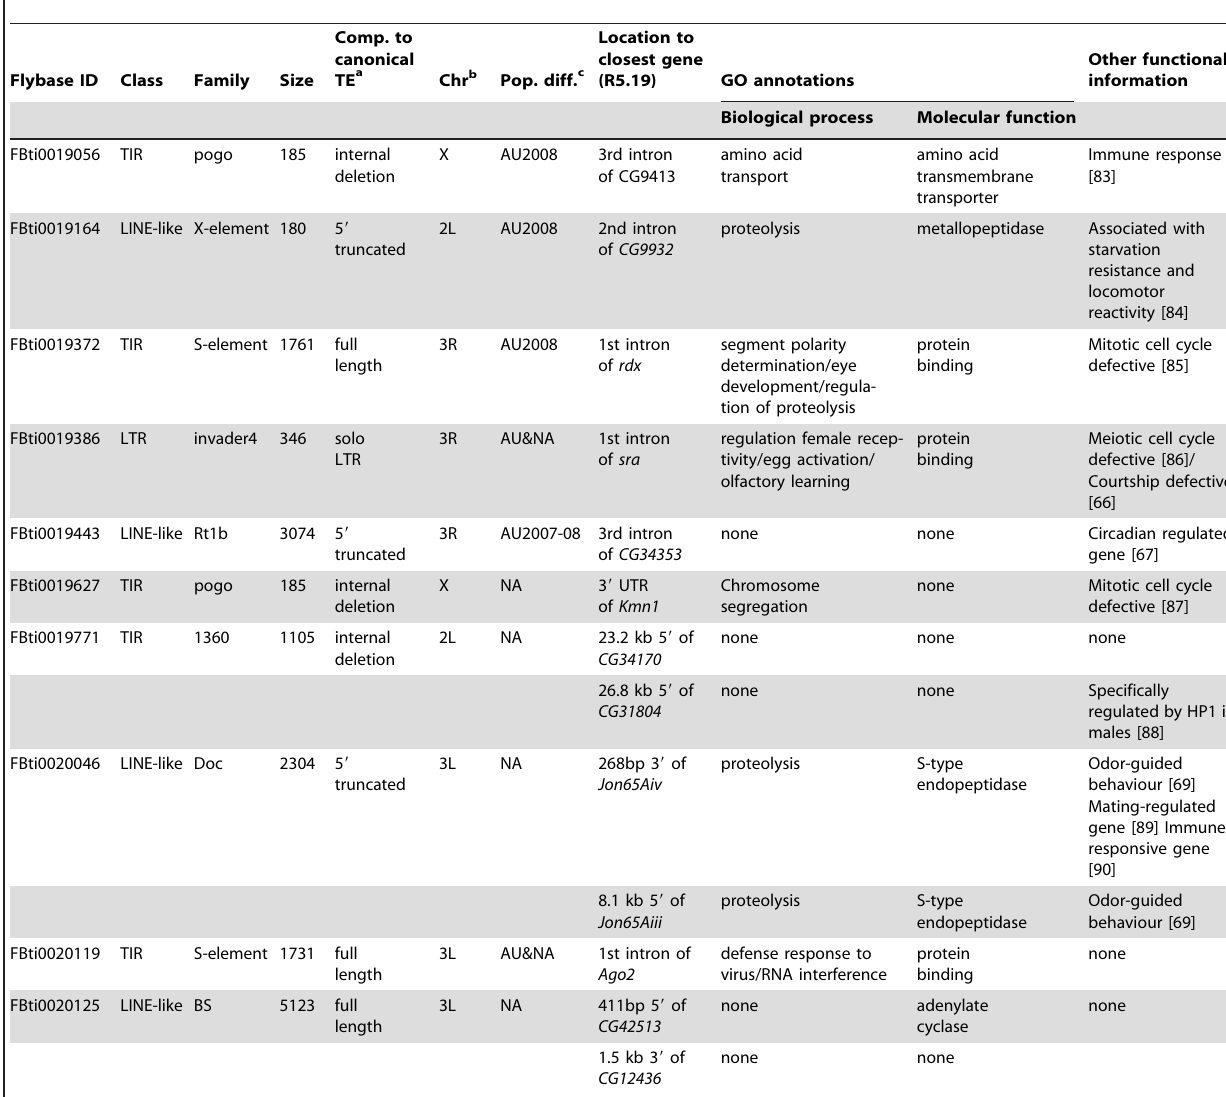
Table 3. Characteristics of the 10 TEs associated with adaptation to the temperate environments.